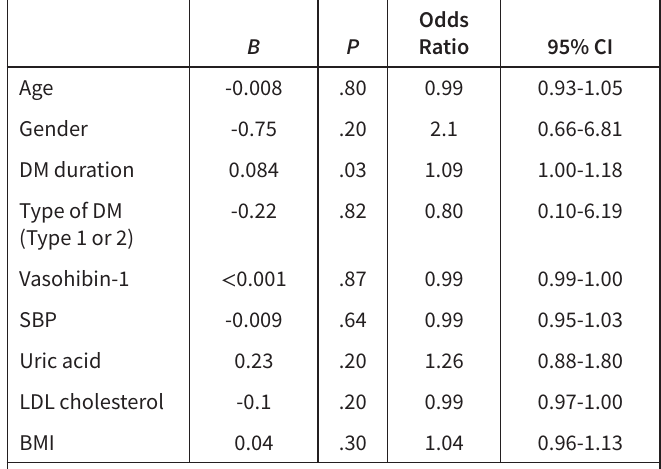
Table 4. Factors Affecting the Development of Nephropathy in the Diabetic Patient Group (Logistic